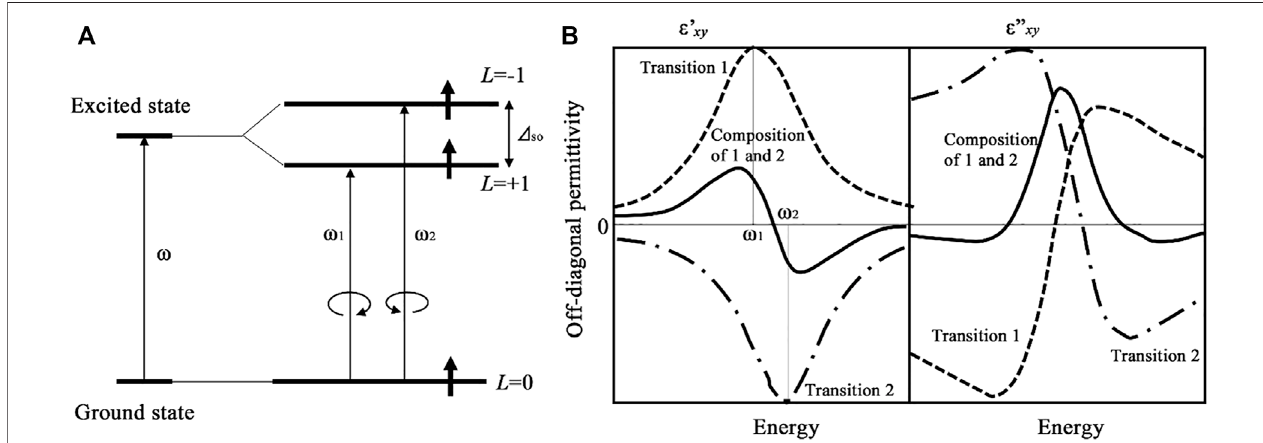
FIGURE 6 | Diamagnetic term of magneto-optical spectra (A) Energy level diagram with spin-orbit split excited state (B) Diamagnetic spectra of off-diagonal dielectric permittivity elements.